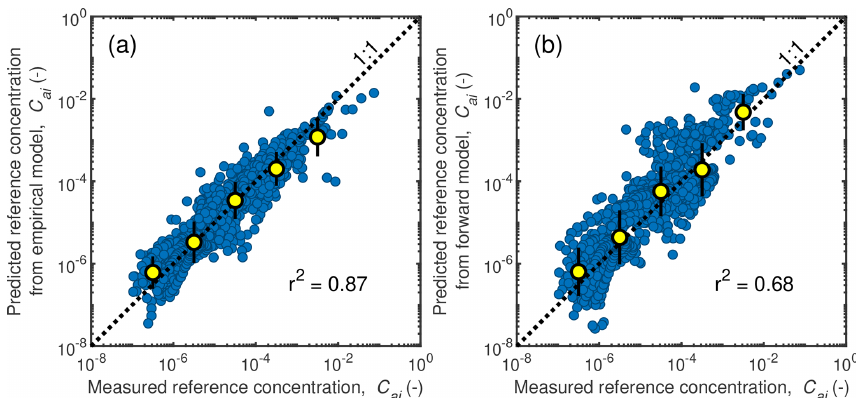
Figure 14. Measured versus predicted grain-size-specific near-bed concentration, C ai , at the reference level z = 0 . 1 H for (a) our two- parameter empirical relation (Eq. 25) and (b) for the forward modeling approach using the bedload-layer equations (Sect. 4.3). Data (blue markers) are from the entire database of suspended sand described in Sect. 2.1 (Table S1) at z = 0 . 1 H . Yellow symbols are the geometric mean, and the error bars indicate the geometric standard deviation within each